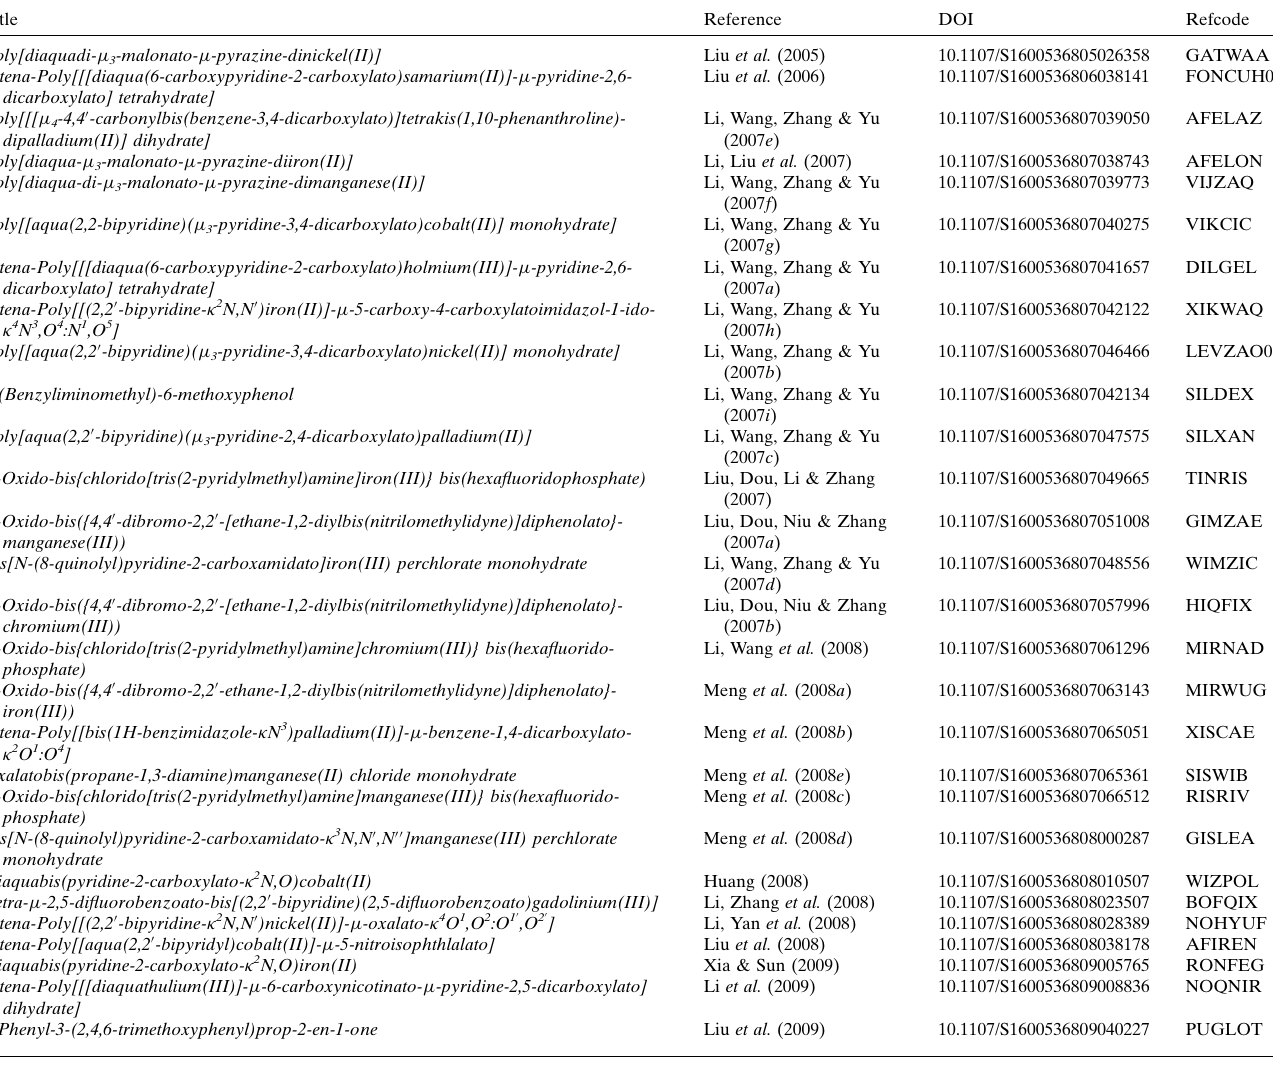
Details of articles to be retracted, in order of